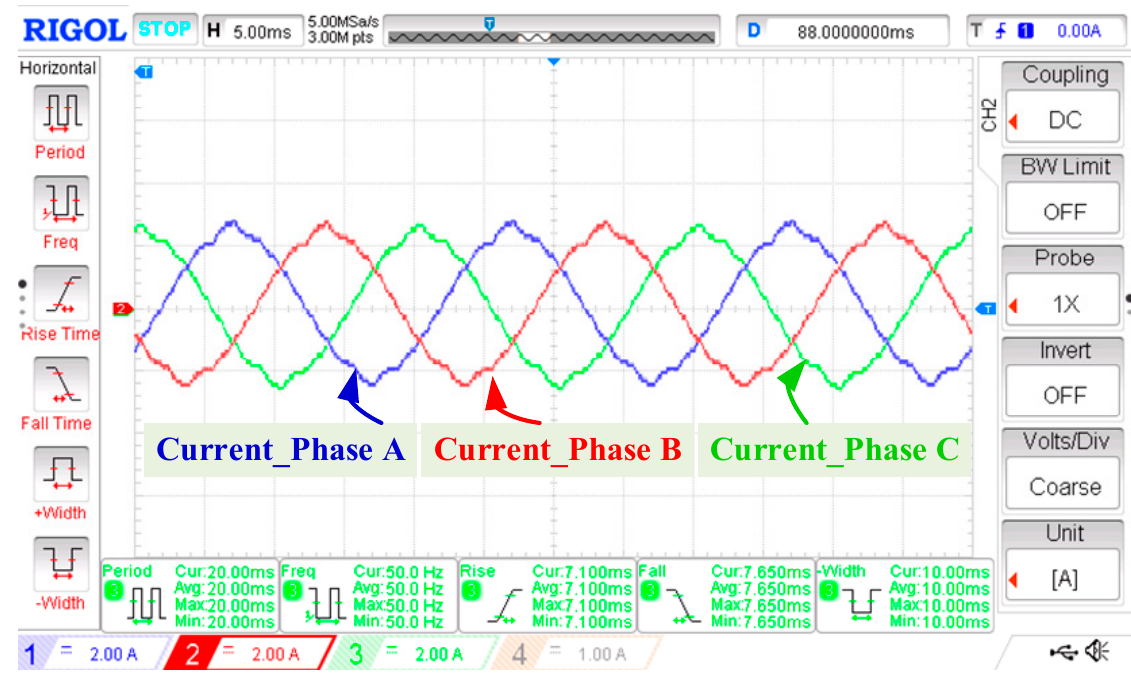
Figure 17. HIL result: phase currents through the three-phase load.